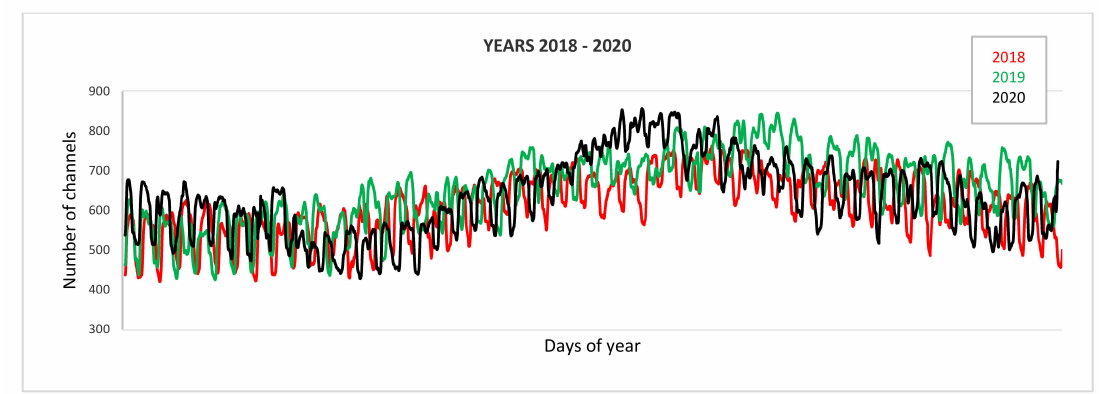
Figure 7. Results corresponding to the number of channels constituted from 2018 to 2020 in the entire geographical area under study.